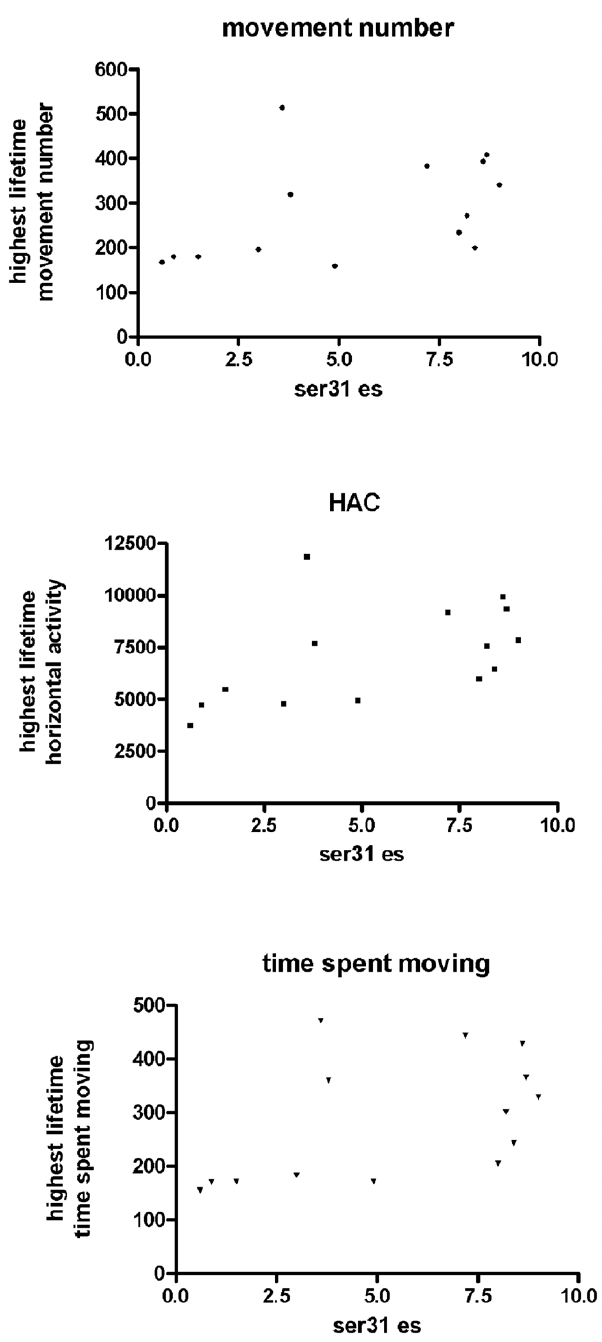
Figure 9. Effective stoichiometry at ser31 and locomotor activity. Effective stoichiometry of ser31 (the product of ser31 phosphorylation stoichiometry and TH protein quantity) correlates with the highest ever recorded locomotor activity measures (movement number, horizontal activity, and time spent moving) of the 17 trials for each test subject. Spearman correlation stats are as follows; move- ment number (a) , r=0.59, p =0.03, horizontal activity (b) , r=0.65, p =.01, time spent moving (c) , r=0.57, p coincident measures of both striatal and nigral DA that are associated with longitudinally-characterized locomotor activity, make a case that nigral DA has a role in modulating basal ganglia circuitry to facilitate the generation of locomotor activity.